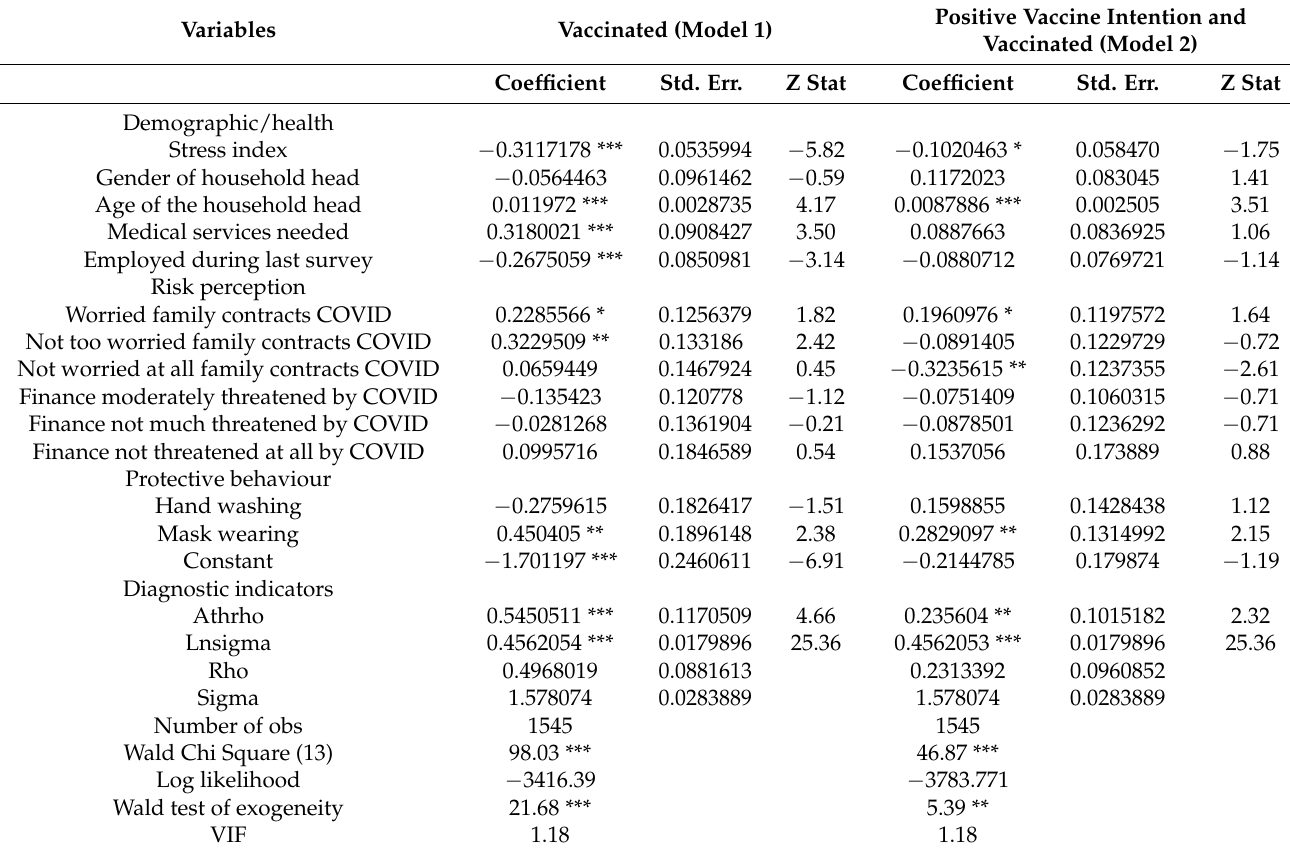
Table 4. Instrumental Variable (IV) Probit Result of the Determinants of COVID-19 Vaccination